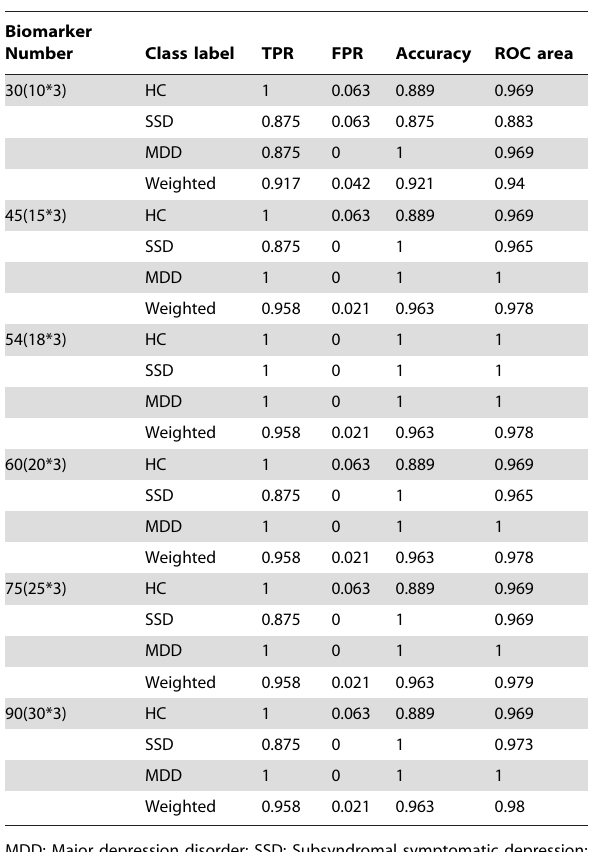
Table 2. Predictive performances of disorder model.